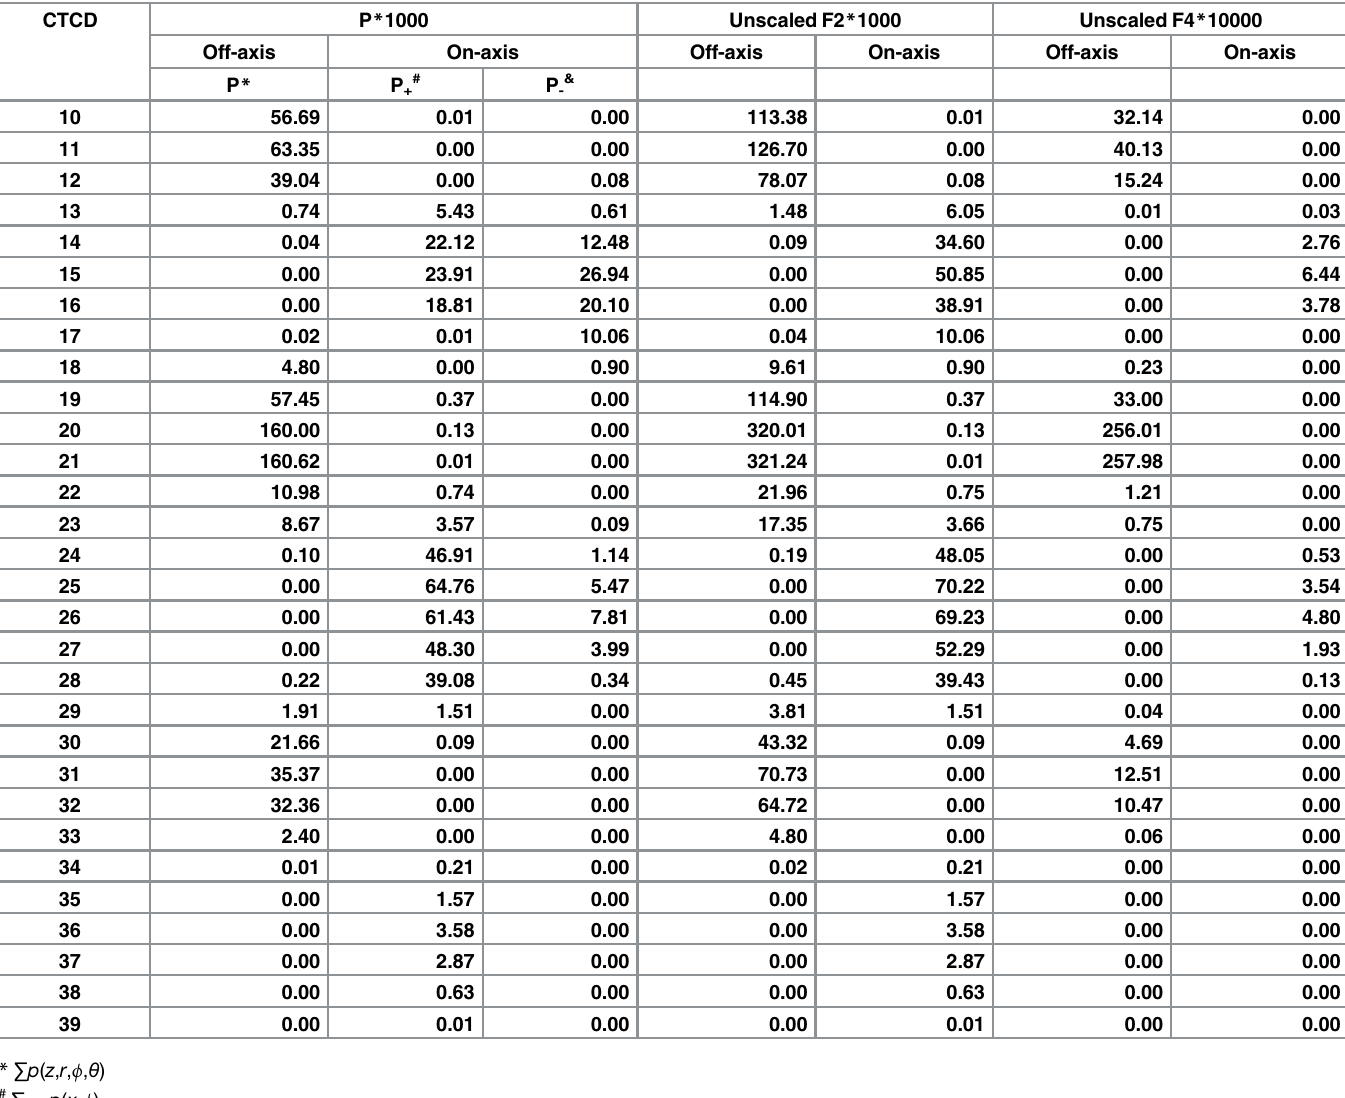
Table 3. Computed probability sums and raw feasibility measures using 10.5 bps/turn